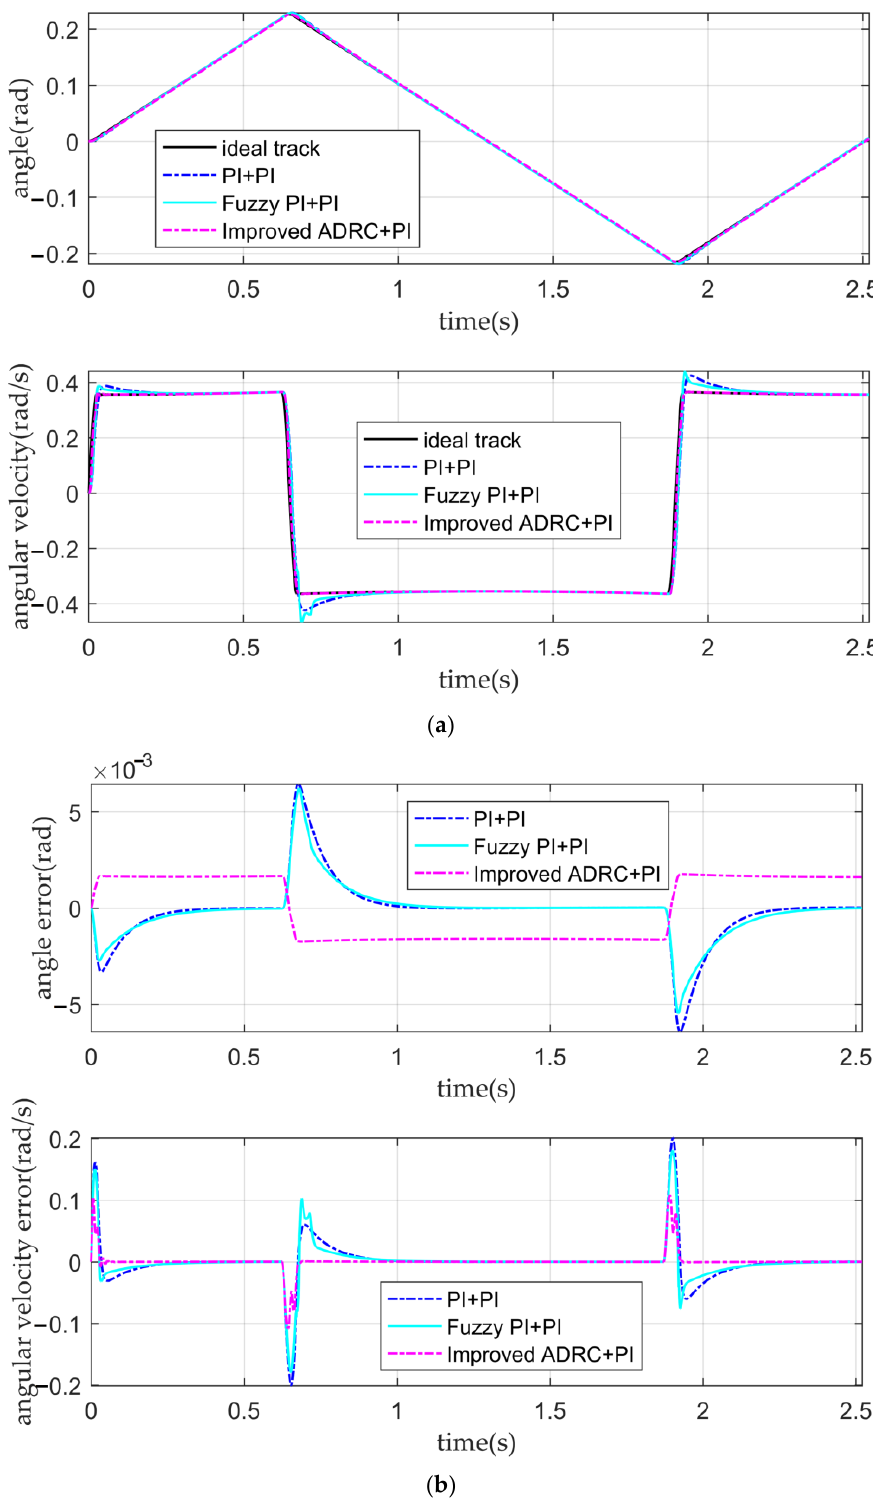
Figure 10. The tracking curves and the error curves. ( a ) The angular displacement tracking curves and the angular velocity tracking curves of the classical PI double closed-loop controller, the fuzzy PI double closed-loop controller, and the IADR-DCLC; ( b ) the angular displacement error curves and the angular velocity error curves of the classical PI double closed-loop controller, the fuzzy PI double closed-loop controller, and the